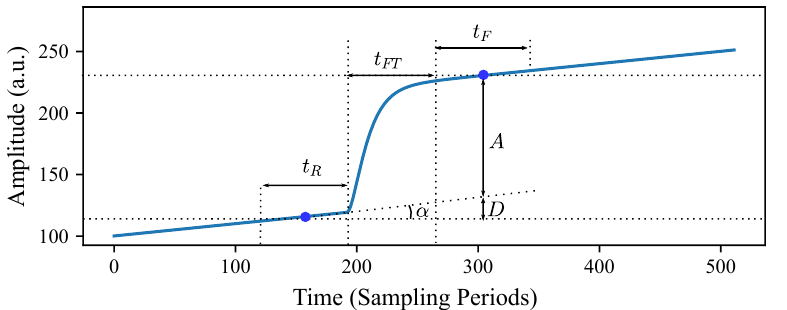
Figure 5. Typical photon pulse with its geometrical features highlighted. The two points in the middle of t R and t F segments correspond to their average